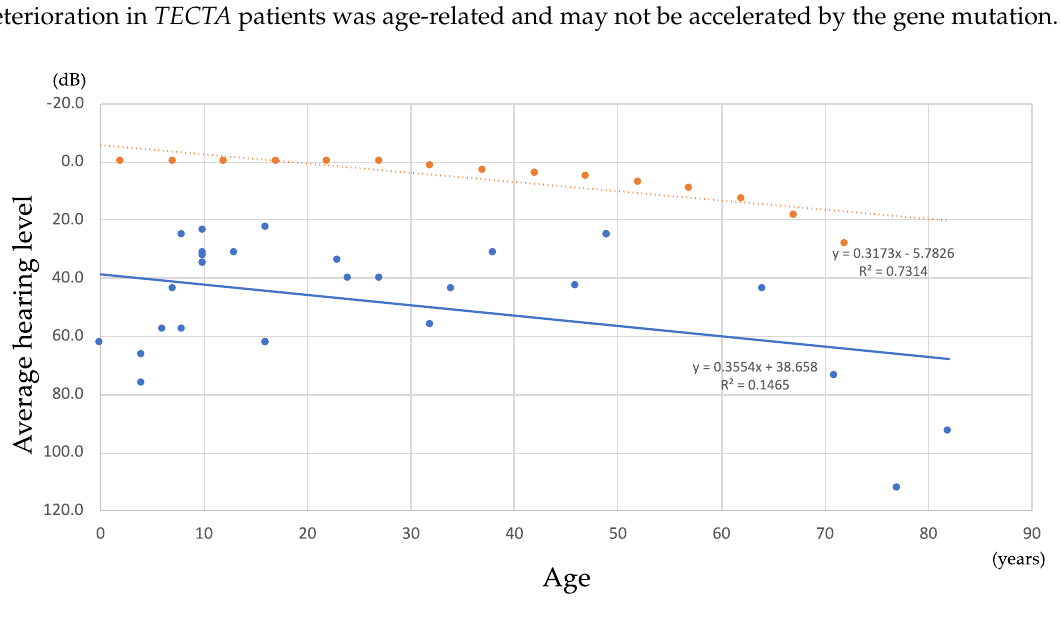
Figure 3. Detailed progression analysis of HL deterioration for patients with TECTA mutations. Lines indicate the linear regression for each group. Blue dots indicate the pure-tone average (PTA) of each patient with TECTA variants. Red dots indicating the PTA for Japanese normal hearing control population (Tsuiki et al. Audiology Japan 2003, 46, 235–240, in Japanese).